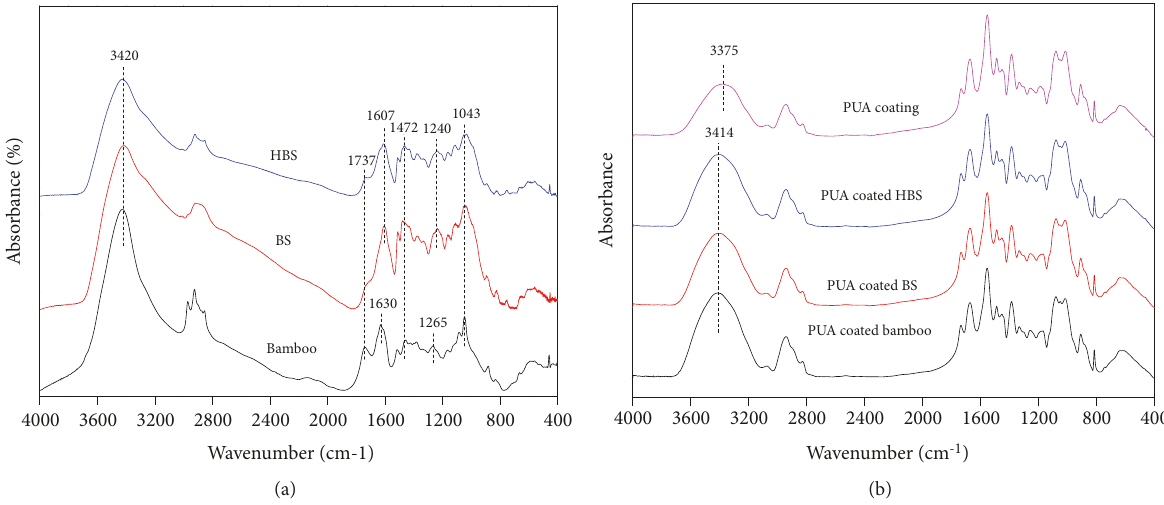
Figure 4: ATR-FTIR spectra of bamboo, BS, HBS (a), and their coated samples (b).